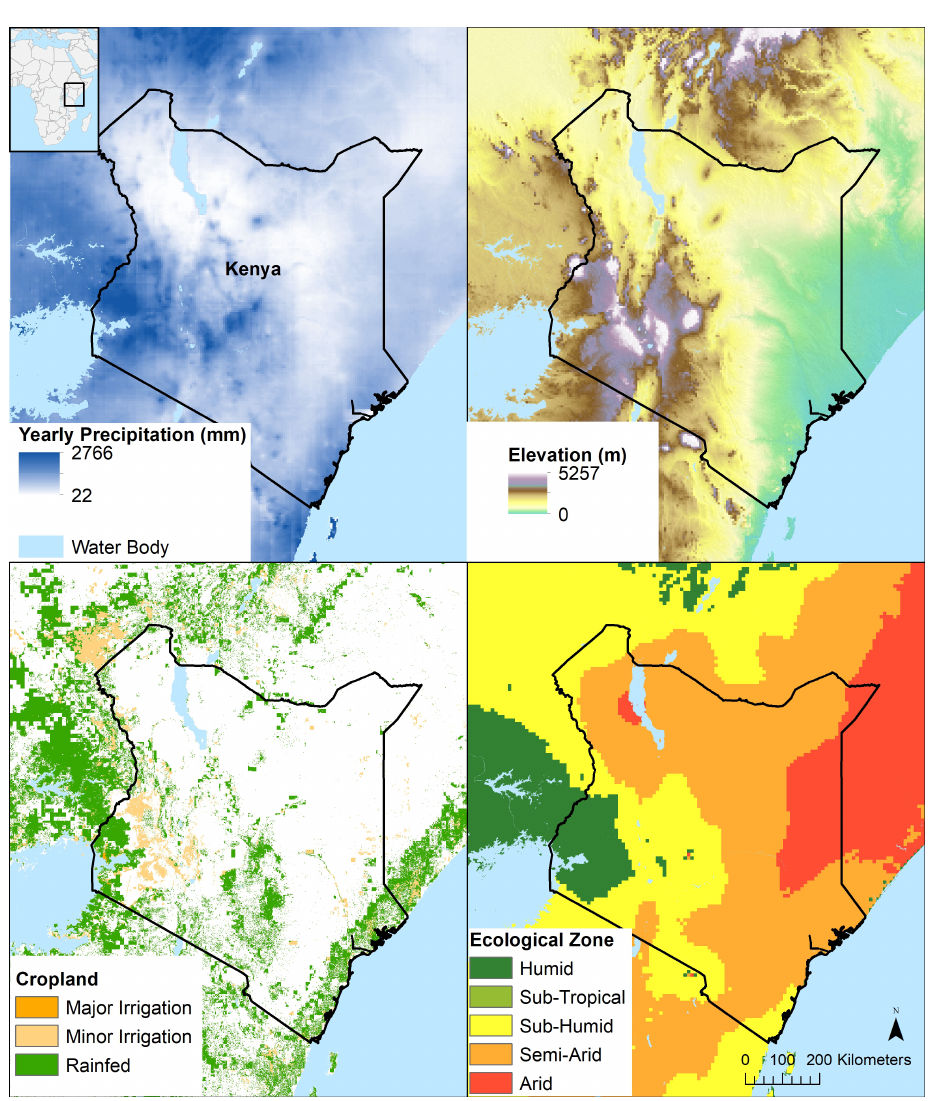
Figure 1. Yearly precipitation in Kenya from CHIRPS ( top left ) [35], elevation ( top right ) [40], cropland from Global Food-Support Analysis Data ( bottom left ) [41], and ecological zone ( bottom right )